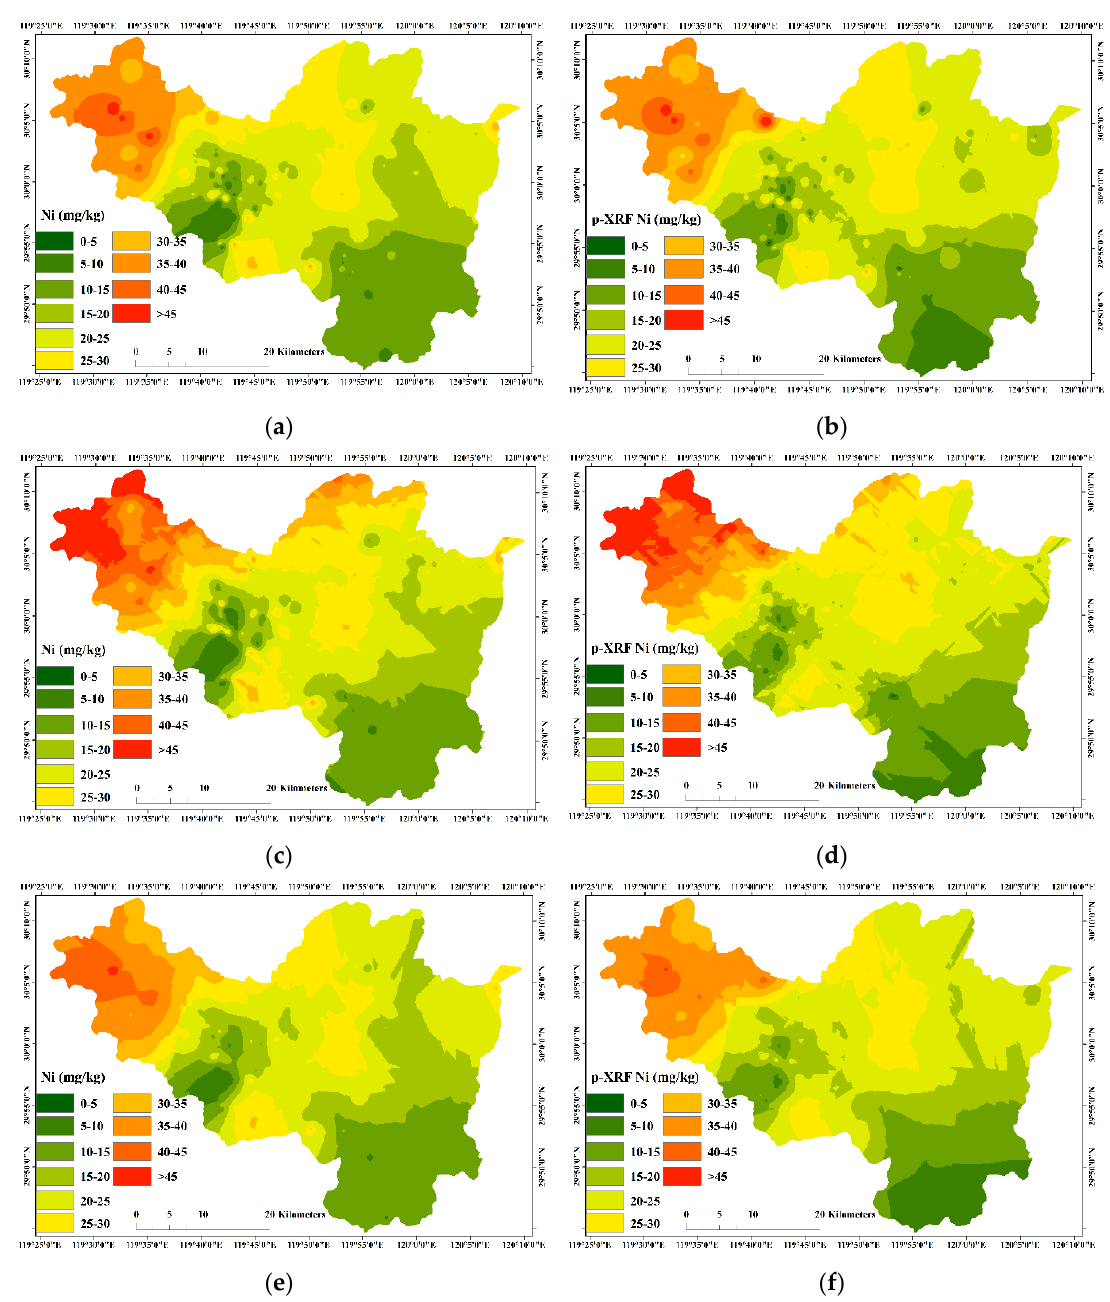
Figure 7. Maps of Ni content measured by LC-ICP-MS (left column) and p-XRF (right column) using IDW ( a , b ), OK ( c , d ), and EBK ( e , f ) geostatistical methods.